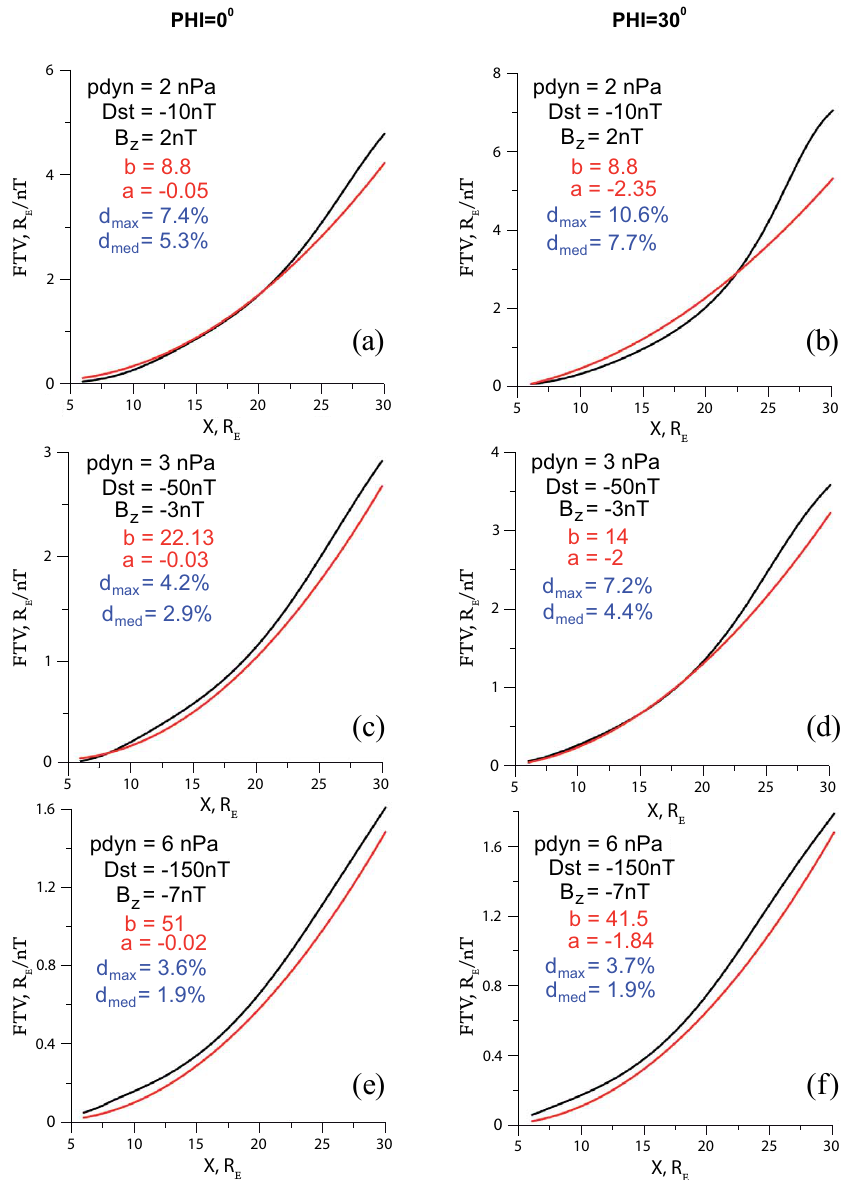
Figure 4. Flux tube volumes: analytical solution (red curves) and T96 (black curves) for quiet (a, b) , substorm (c, d) and storm (e, f) conditions are plotted for tilt angles 0 ◦ (a, c, e) and PHI = 30 ◦ clockwise (b, d, f) . Input parameters for the T96 model (black text), for the Kan-like model (red text), and SD normalized for average FTV (blue text) are given in legends. The Earth is on the